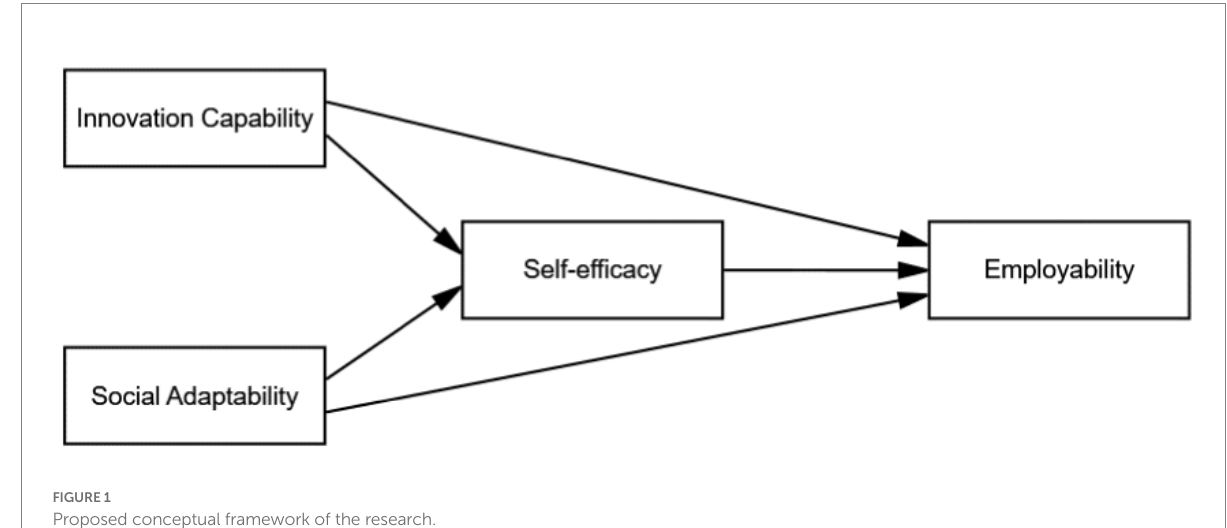
FIGURE 1 Proposed conceptual framework of the